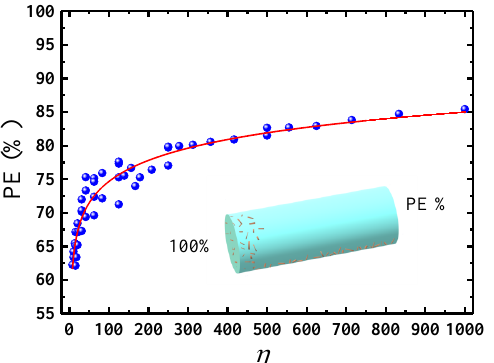
Figure 13. Penetration efficiency as a function of related synthetic parameter. ●: numerical data and — : expression (15).